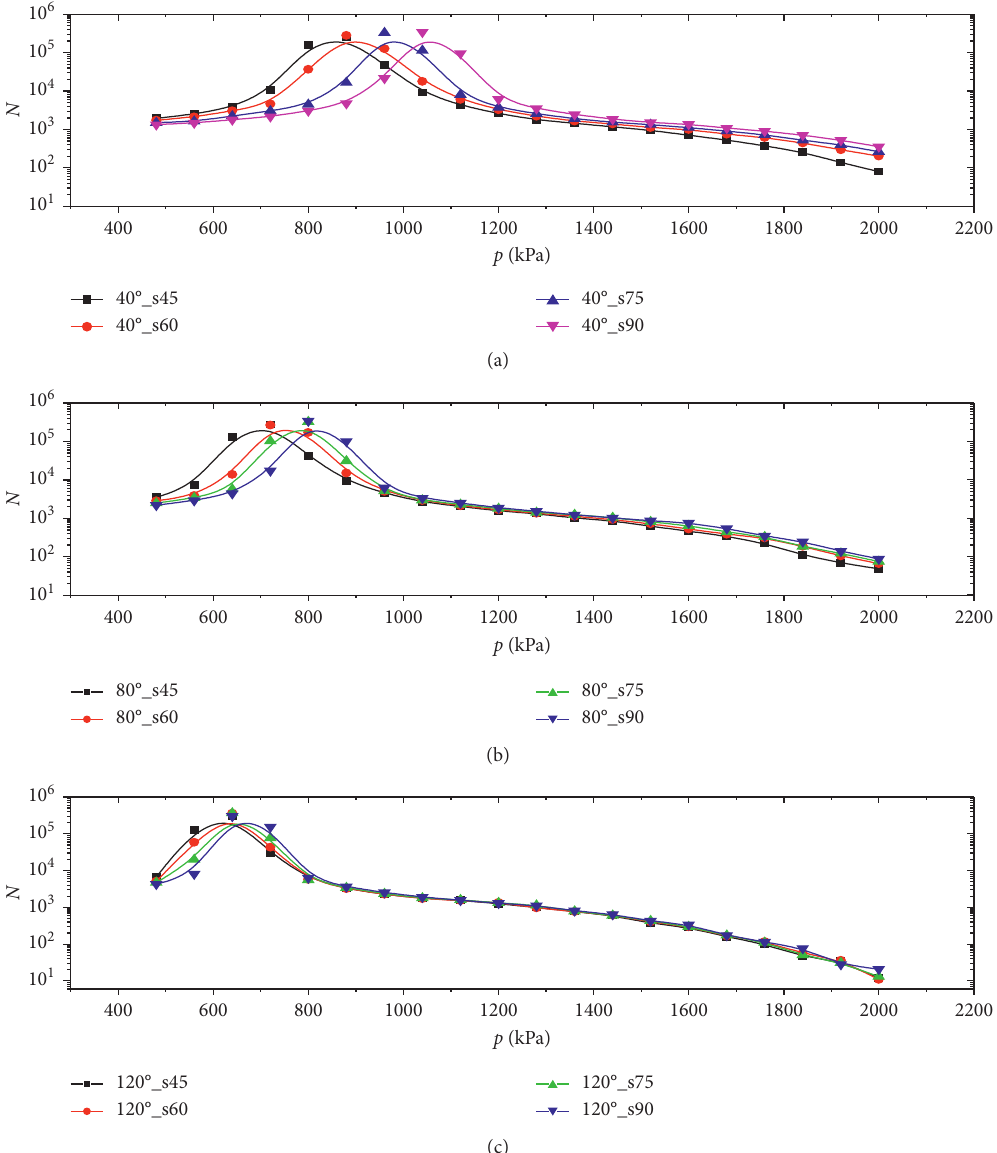
Figure 14: Number density versus peak height with different stand-off distances ( σ � 0 .